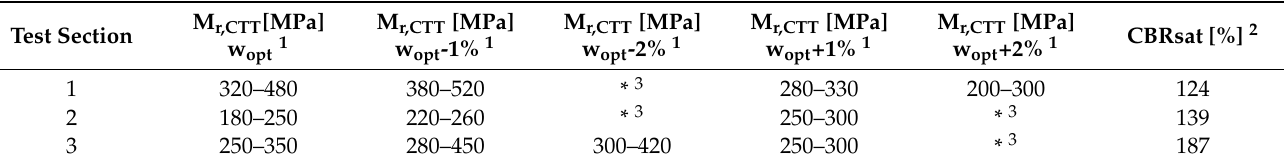
Table 2. Average M r,CTT values and approximate values of CBR for subbase layers of the monitored road sections.